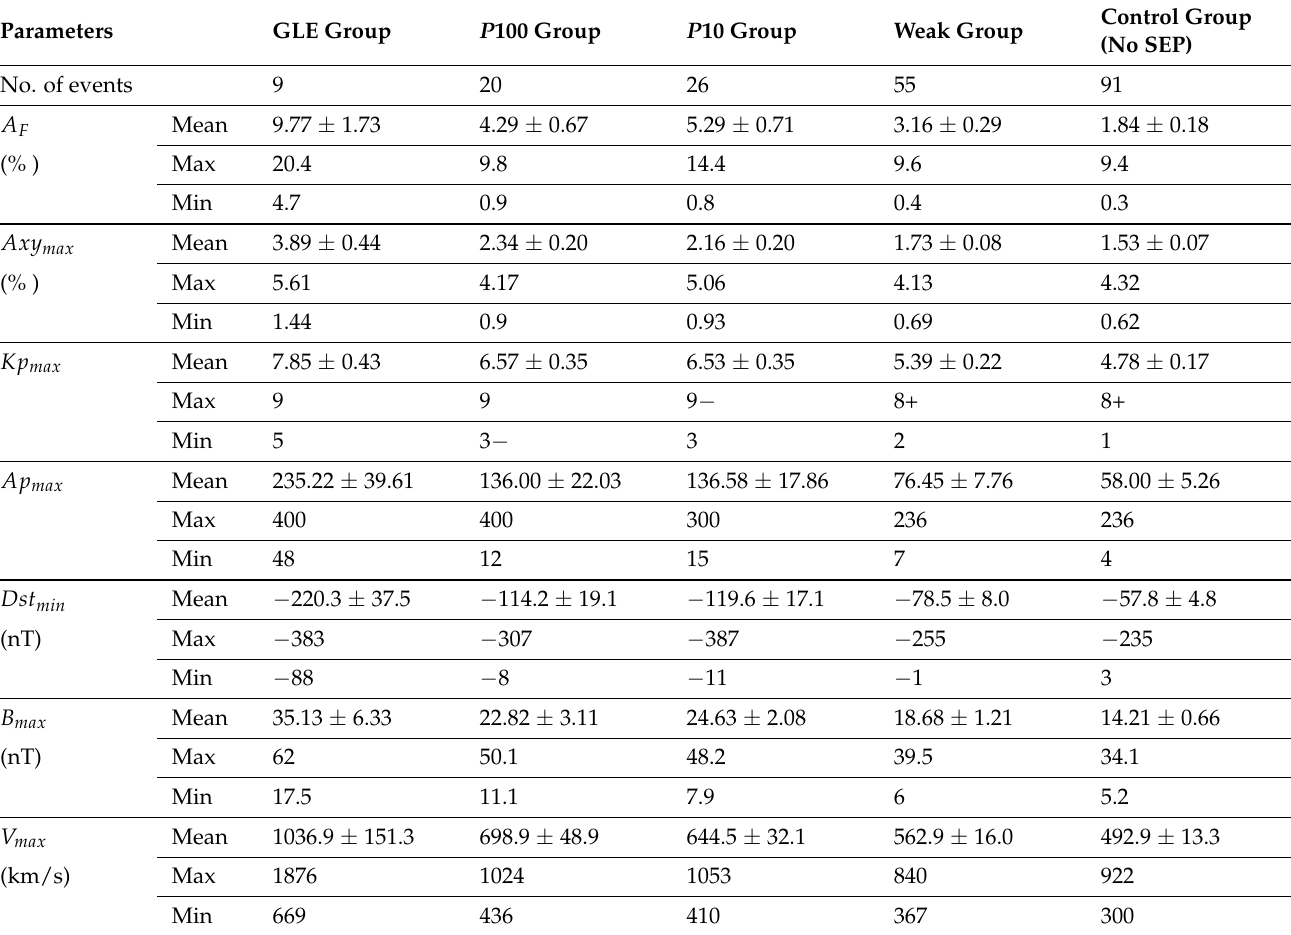
Table 2. Mean, maximum, and minimum values of the main SW, IMF, CR, and GA parameters for the researched